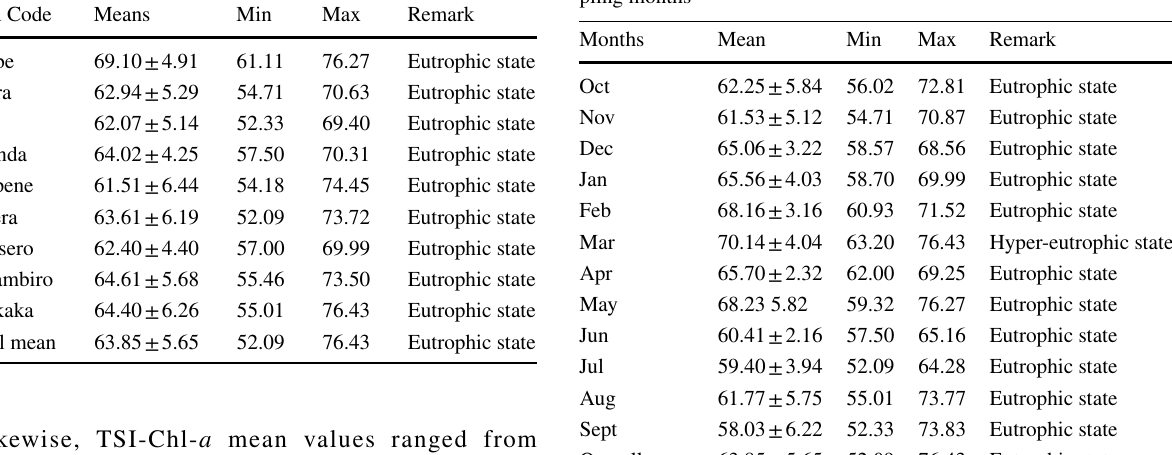
Table 8 Mean ± Std. Dev. and range of the CTSI values between sam- pling months Months Max